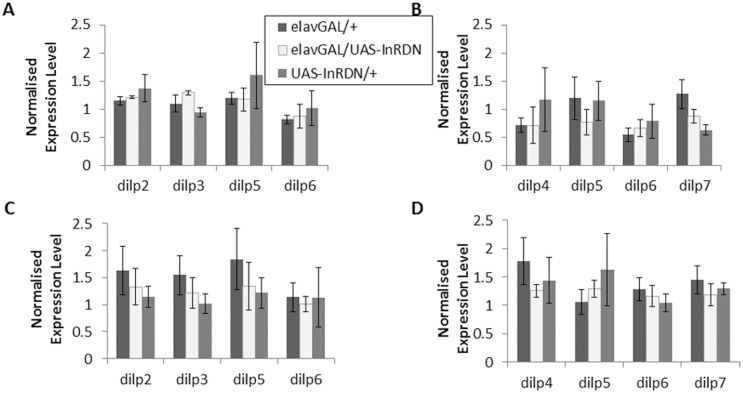
The Effect of InRDN Expression on dilp Expression.
(A-D) The effect of UAS-InRDN expression in CNS neurons on dilp expression in 10 day old adult male and female heads and bodies was measured by quantitative RT-PCR, and N = 3 (groups of 20 heads or bodies) for each genotype. (A) dilp 2, 3, 5 and 6 relative transcript levels in elavGAL/UAS-InRDN and control female heads. (B) dilp 4, 5, 6 and 7 relative transcript levels in elavGAL/UAS-InRDN and control female bodies. (C) dilp 2, 3, 5 and 6 relative transcript levels in elavGAL/UAS-InRDN and control male heads. (D) dilp 4, 5, 6 and 7 relative transcript levels in elavGAL/UAS-InRDN and control male bodies. Data are shown as mean relative expression level ±SEM (N = 3).